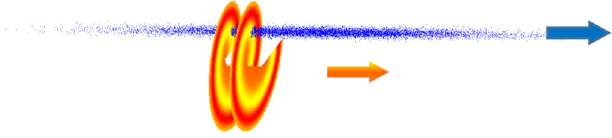
FIG. 1. Sketch of Bessel light beam (red-orange vortex) interaction with electron beam (blue